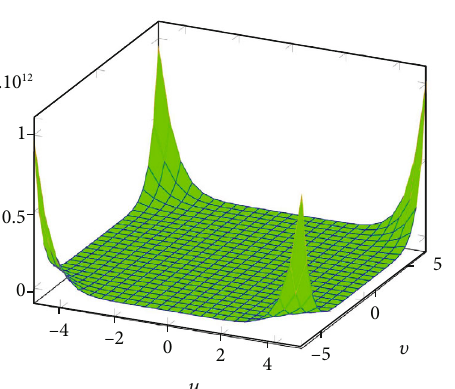
Figure 2: 3D plot of NM-polynomial of starphene ð St m + n = 12